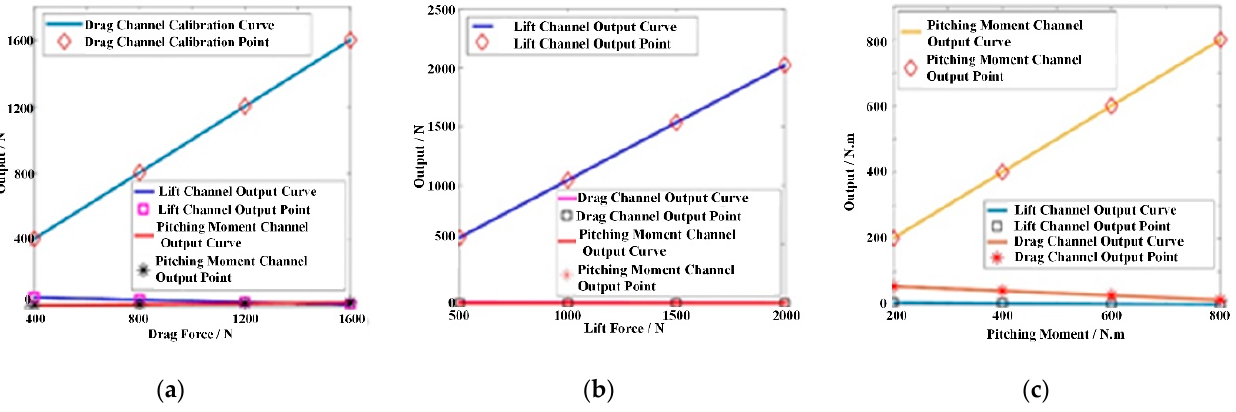
Figure 6. Calibration results for each test channel in the AFMS. ( a ) Drag Force Channel Calibration Curve. ( b ) Lift Force Channel Calibration Curve. ( c ) Pitch Moment Channel Calibration Curve.